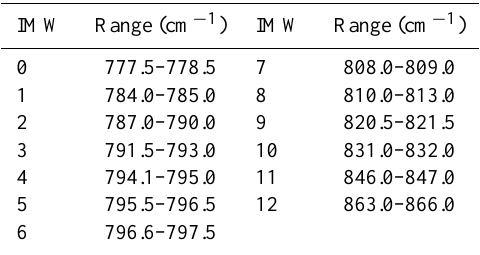
Table 3. A list of employed integrated microwindows (IMW) and their spectral